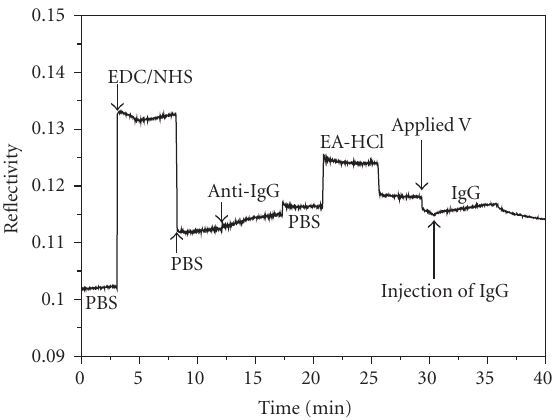
Figure 3: SPR response during construction of PABA-based im- munosensor and sensing of human IgG (1 μ g/mL) at constant applied potential of 0.4V